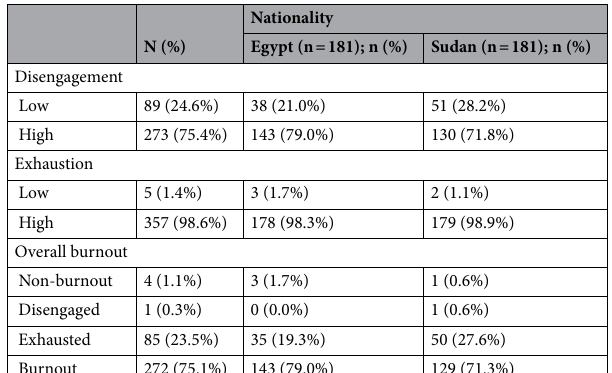
Table 1. Distribution of healthcare professionals working at COVID-19 isolation facilities in Egypt and Sudan according to levels of burnout domains.